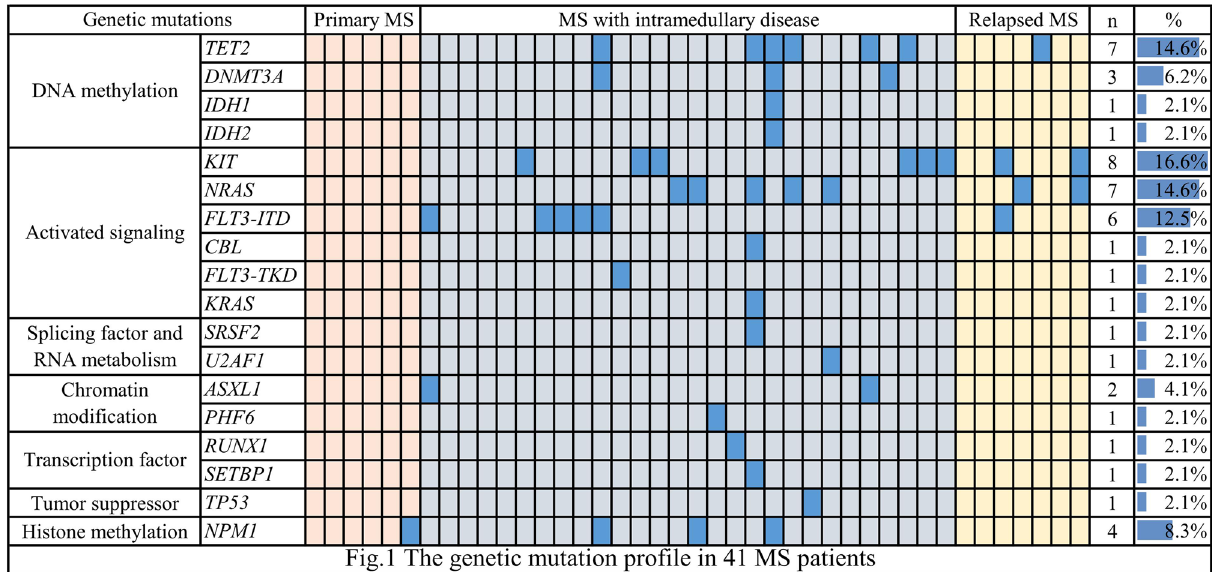
Figure 1. The genetic mutation profile in 41 myeloid sarcoma